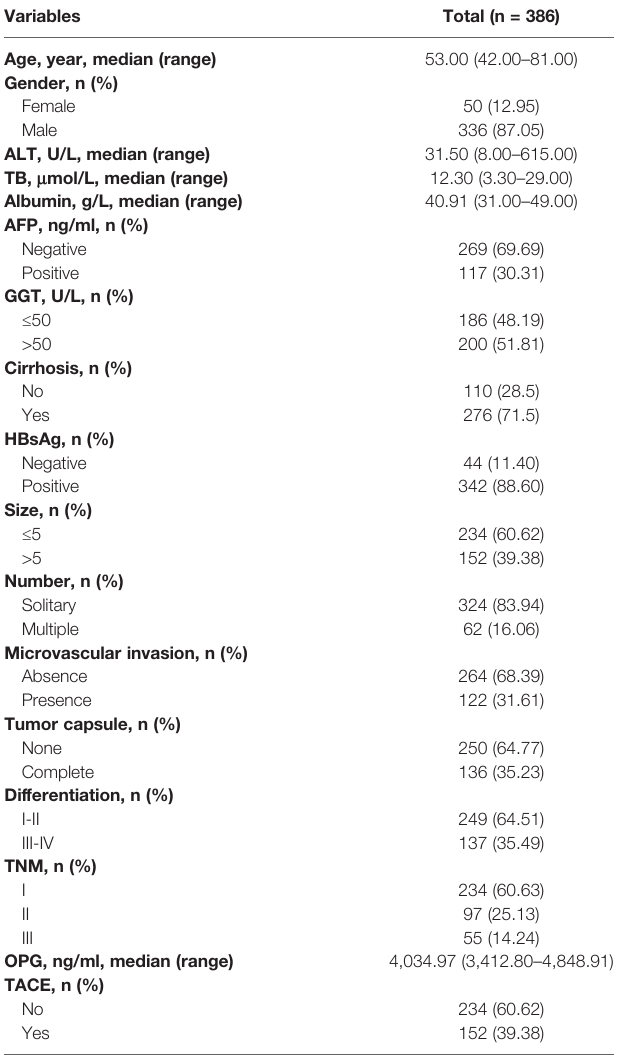
TABLE 1 | Clinicopathological characteristics of patients with hepatocellular carcinoma following curative resection.